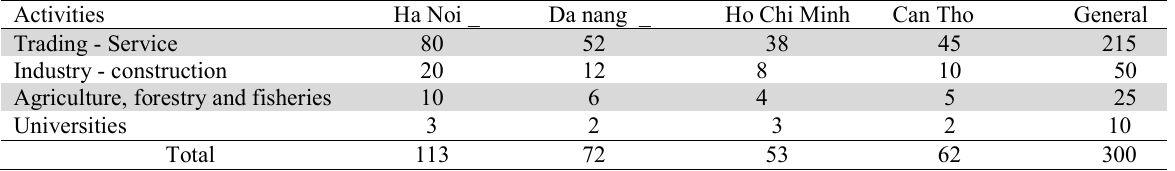
Structure of the sample according to geographical areas and fields of activity